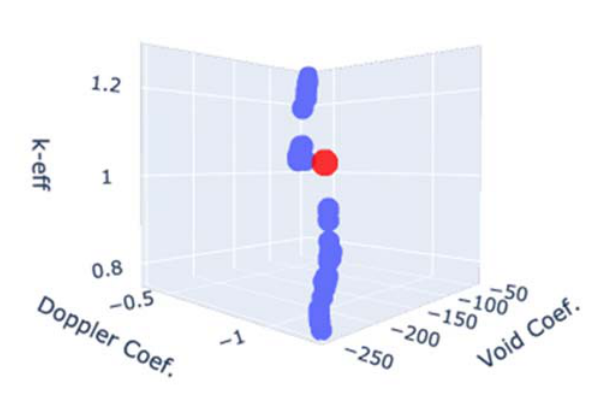
Figure 6: Pareto front for SOGA using a Weighting